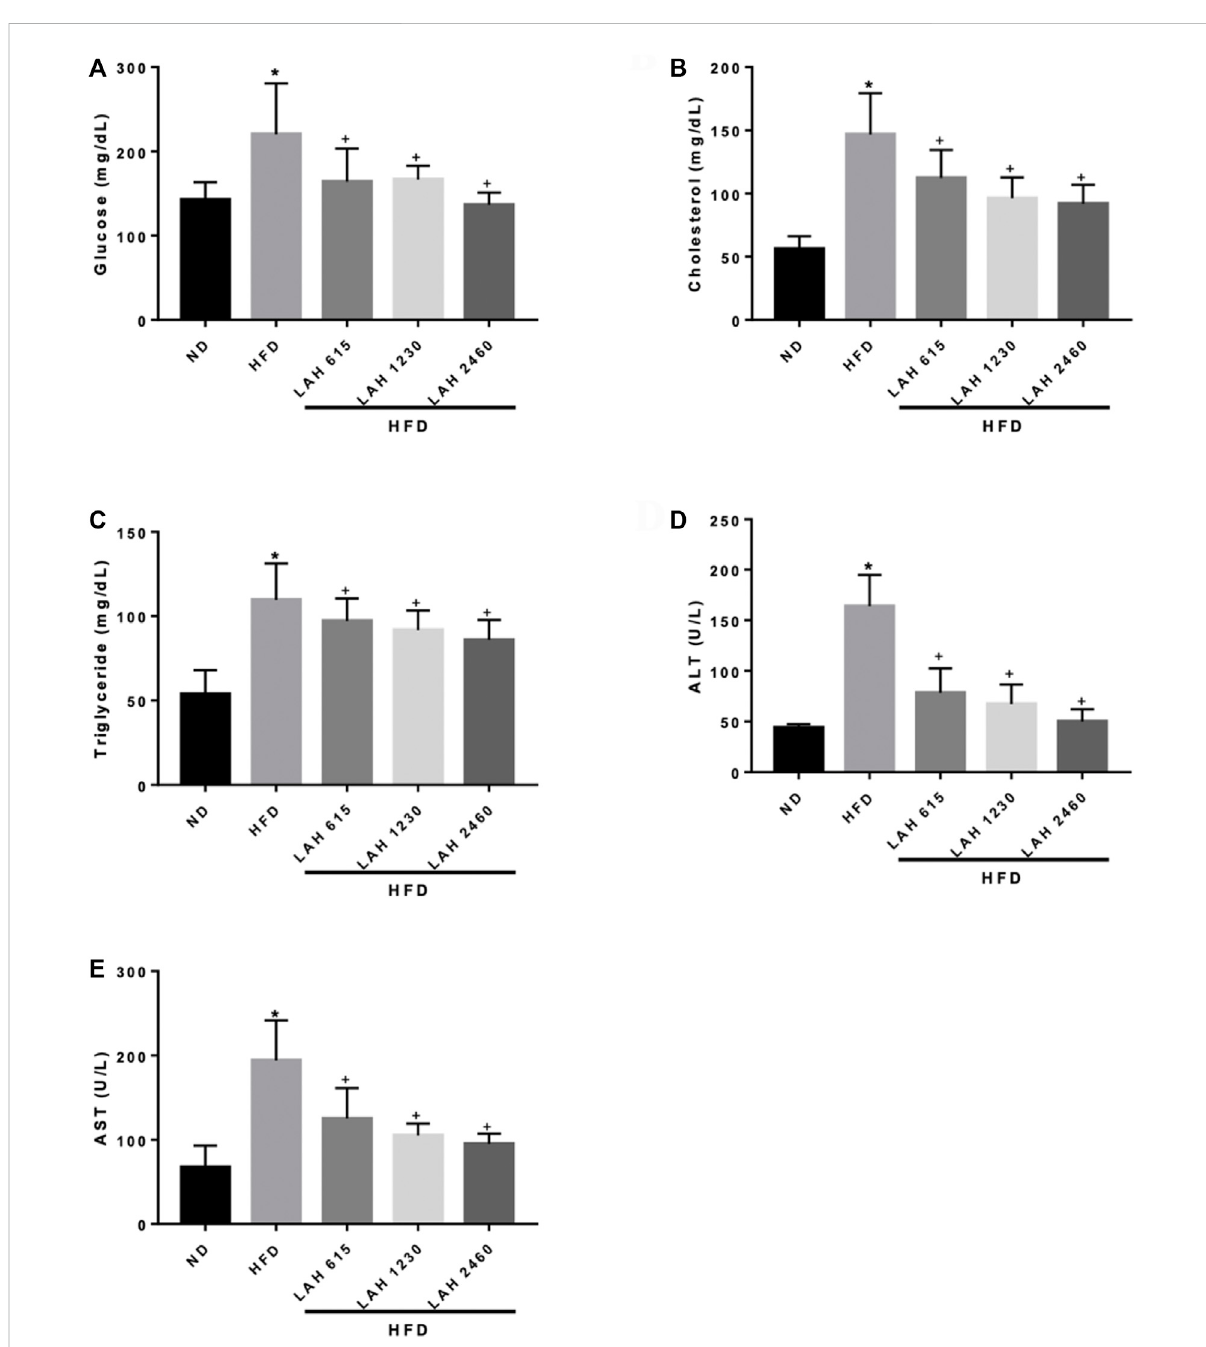
FIGURE 6 Serum biochemical analysis after 18 weeks of supplementation with LAH. Biochemical analysis of serum samples. Levels of (A) Fasting blood glucose, (B) CHOL, (C) TG, (D) ALT,and (E) ASTweremeasuredintheserumofmiceindifferentexperimentalgroups.Valuesareexpressedasmean± SD ( n = 10/group). * p < 0.05 compared with ND group. + p < 0.05, compared with HFD